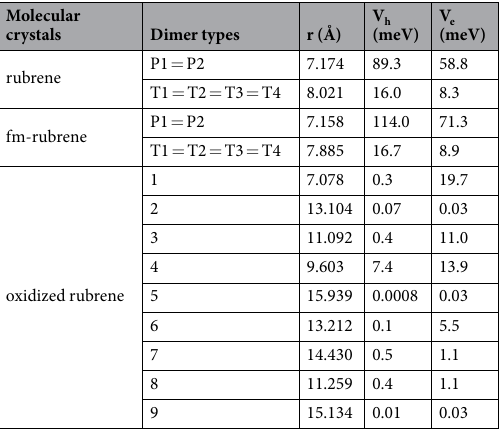
Table 2. Calculated electronic coupling terms V h (for hole-transfer) and V e (for electron-transfer) for the different hopping pathways in rubrene, fm-rubrene and oxidized rubrene crystals; r is the intermolecular center-to-center